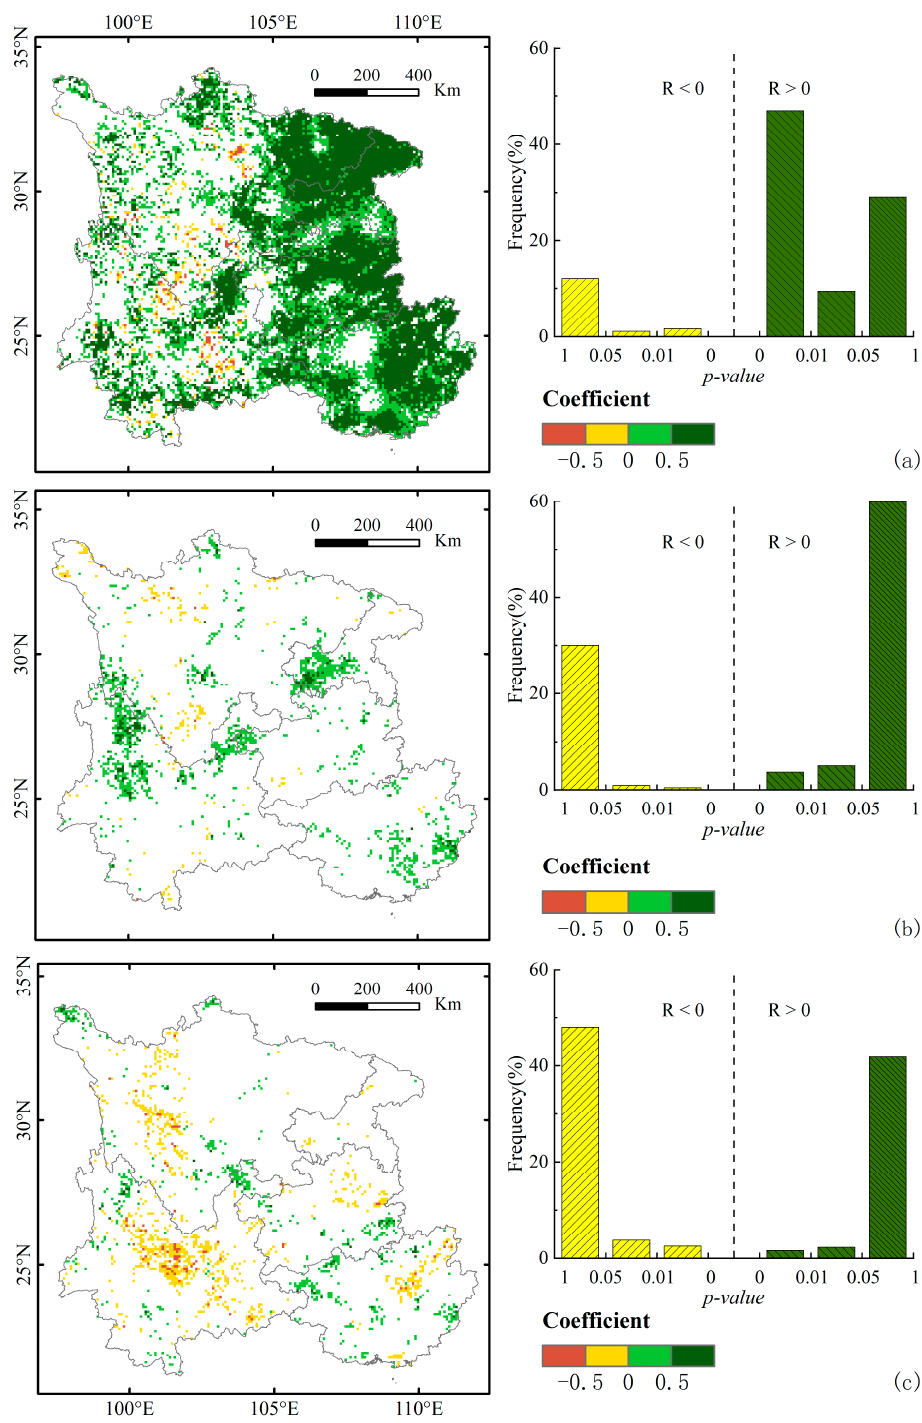
Figure 8. Spatial partial correlation analysis of NDVI and the associated environmental factors including temperature ( a ), precipitation ( b ) and downward shortwave radiation ( c ) across Southwest China during 1982–2015.